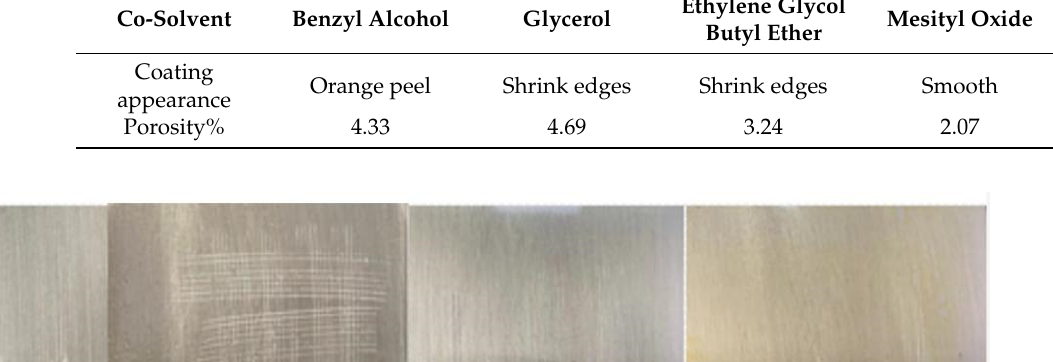
Table 5. Effects of the auxiliary solvent on the performance of the coating.